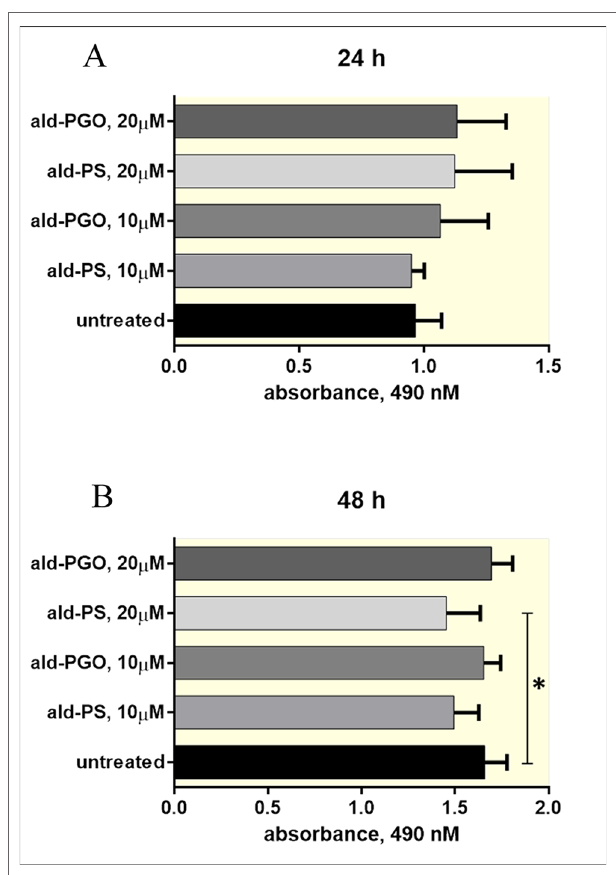
FIGURE 4 | 2 ′ -OMe PGO is not toxic for macrophages. RAW 264.7 cells were treated with 10 and 20 μM of ald -PGO (PGO) or ald -PS (PS) for 24 (A) and 48 h (B) and analyzed for viability by the MTS assay. * p < 0.05. 2 ′ -OMe PGO, phosphoryl guanidine oligo-2 ′ - O